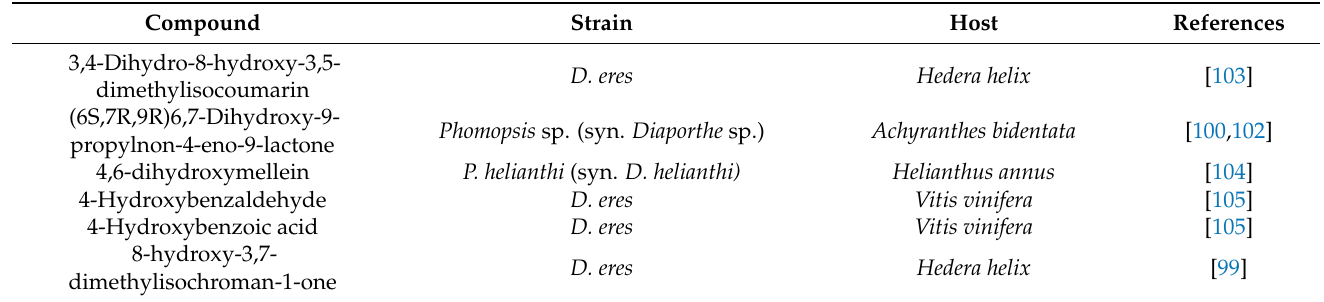
Table 2. Overview of some secondary metabolites isolated from species of Diaporthe and Phomopsis - like species with phytotoxic